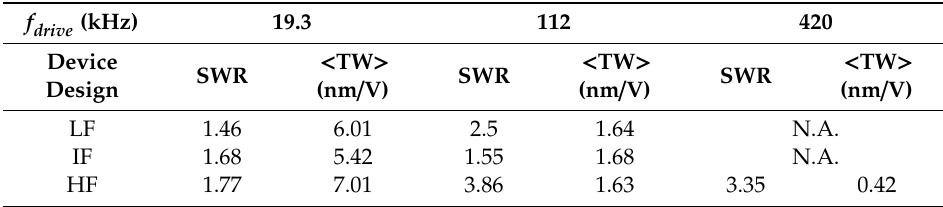
Table 6. Summary of the figures of merit of the di ff erent designs, each of them actuated at the three